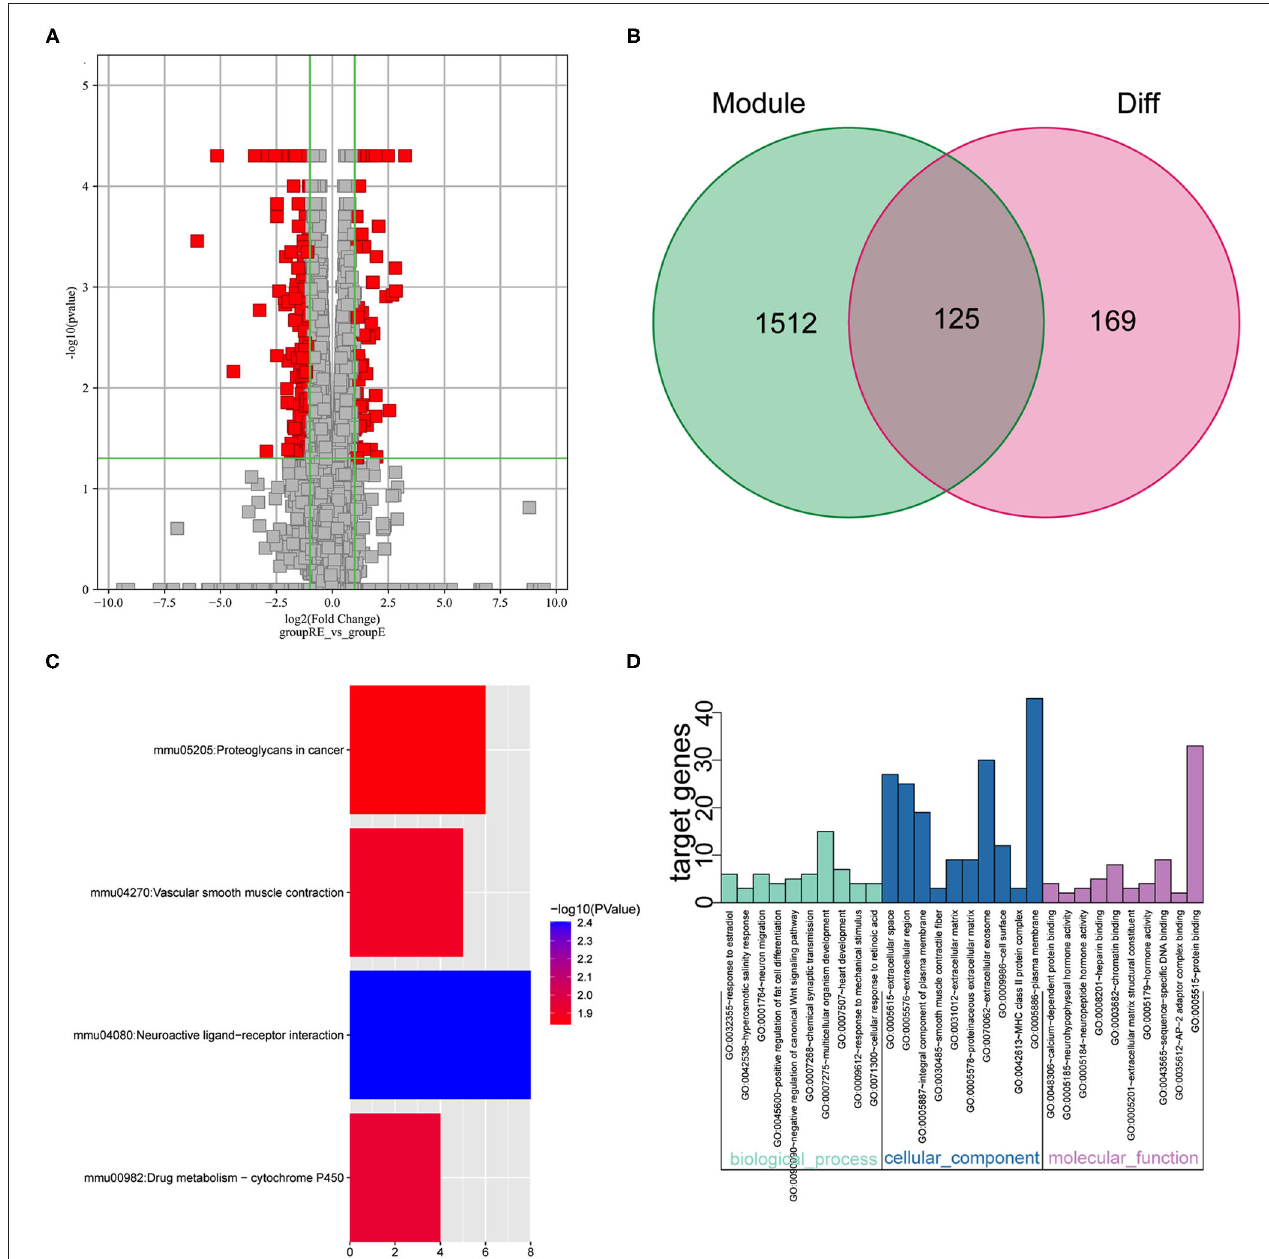
FIGURE 6 | Analysis of key genes in E and RE groups. (A) The DEGs in E and RE groups were analyzed. (B) The obtained mRNAs were presented by the Venn diagram. (C) Four significant pathways were obtained by KEGG enrichment analysis of 125 genes. (D) The top 10 GO-BP, GO-CC, and GO-MF were obtained by GO annotation analysis of 125 genes. E, fear memory extinction group. RE, retrieval-extinction group; DEGs, differentially expressed genes; GO-BP, gene oncology-biological process; GO-CC, gene oncology-cellular component; GO-MF, gene oncology-molecular function; KEGG, Kyoto Encyclopedia of Genes and